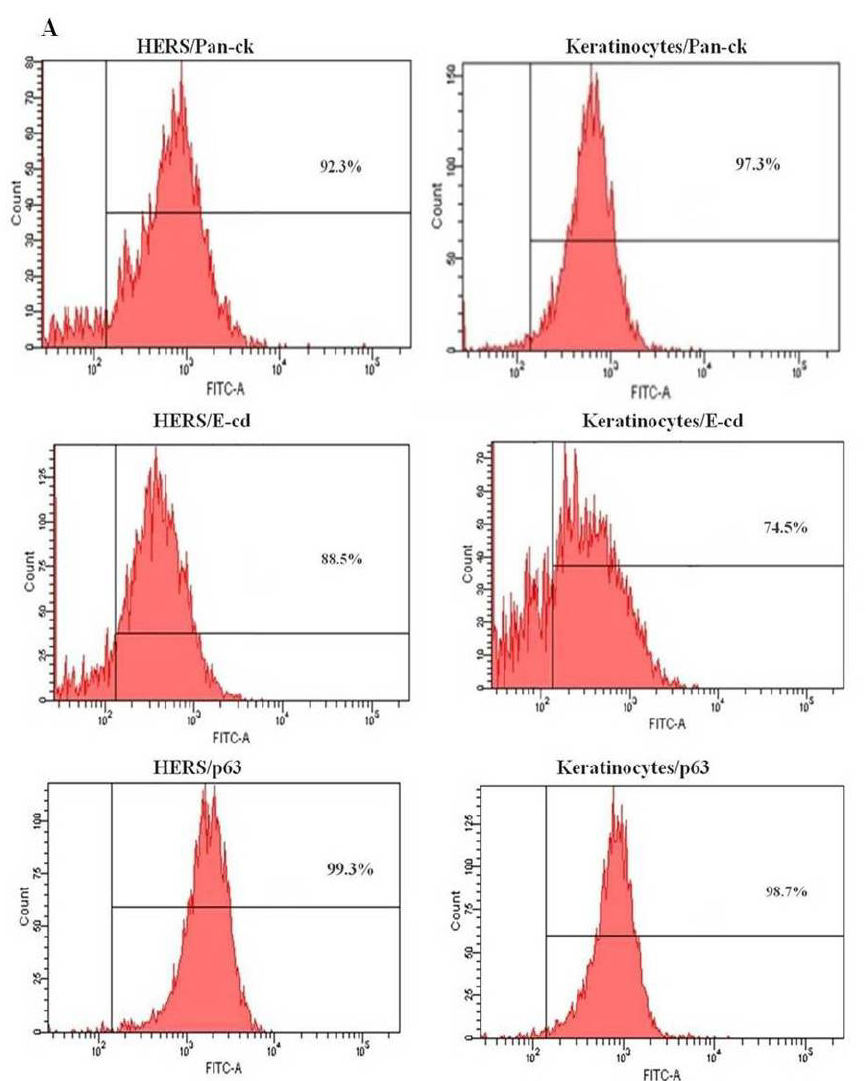
Figure 3. Expression profiles of HERS cells and keratinocytes by flow cytometry